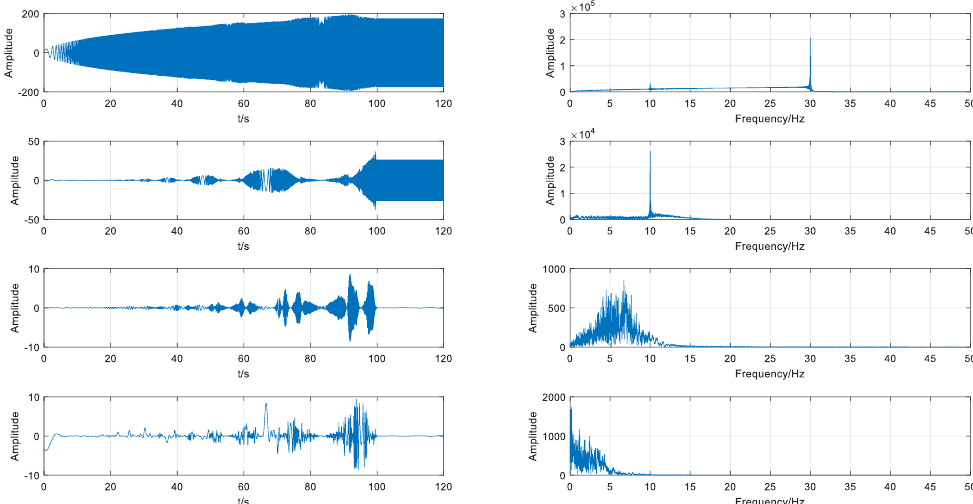
Figure 8. Results of empirical mode decomposition (EMD) from the simulated signal.